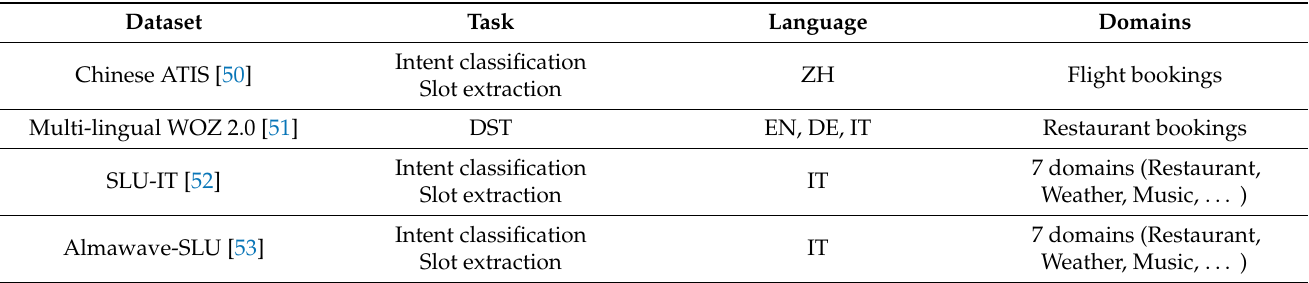
Table 2. Datasets translated from English within the field of task-oriented DS. EN: English, ES: Spanish, DE: German, IT: Italian, TH: Thai, VI: Vietnamese, ZH: Chinese.